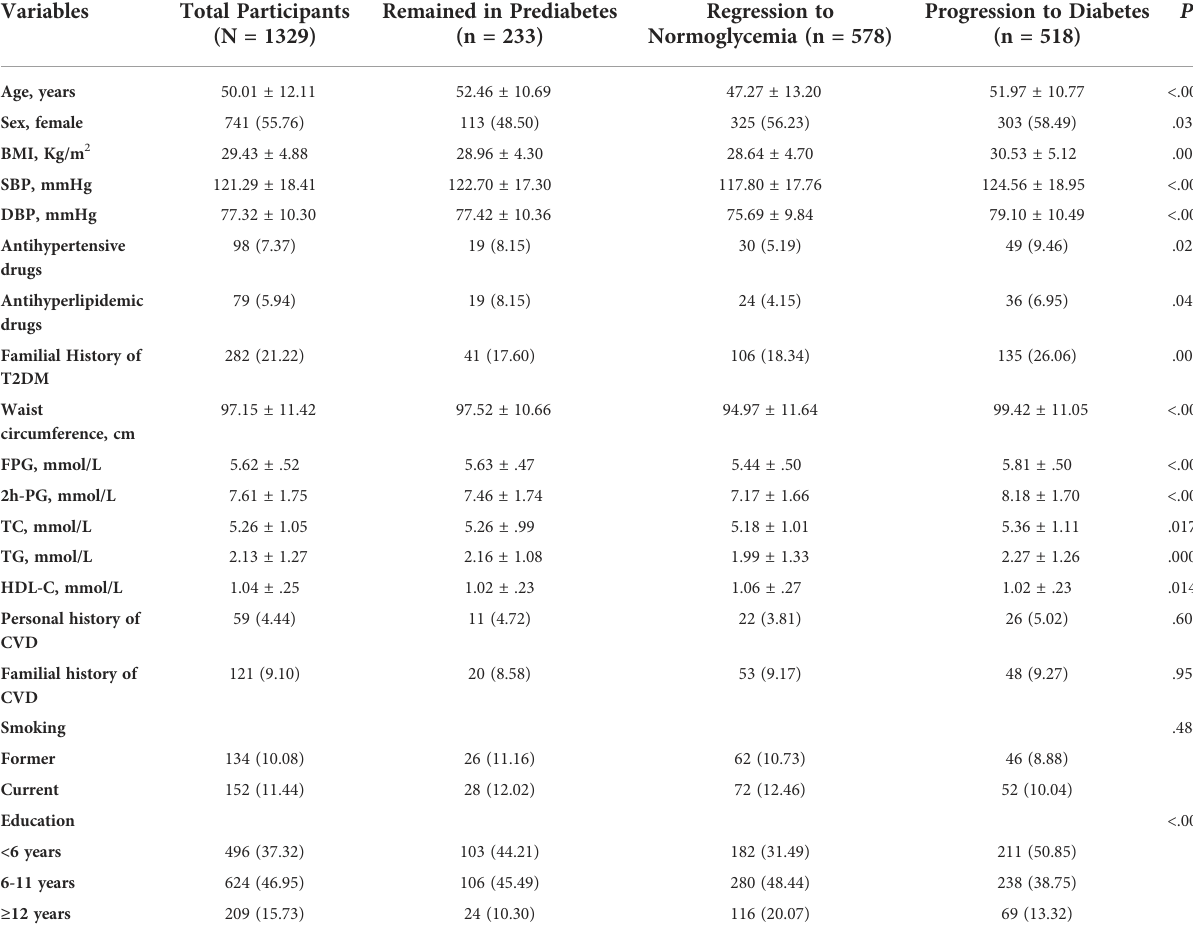
TABLE 1 Baseline characteristics of participants according to transition status a .